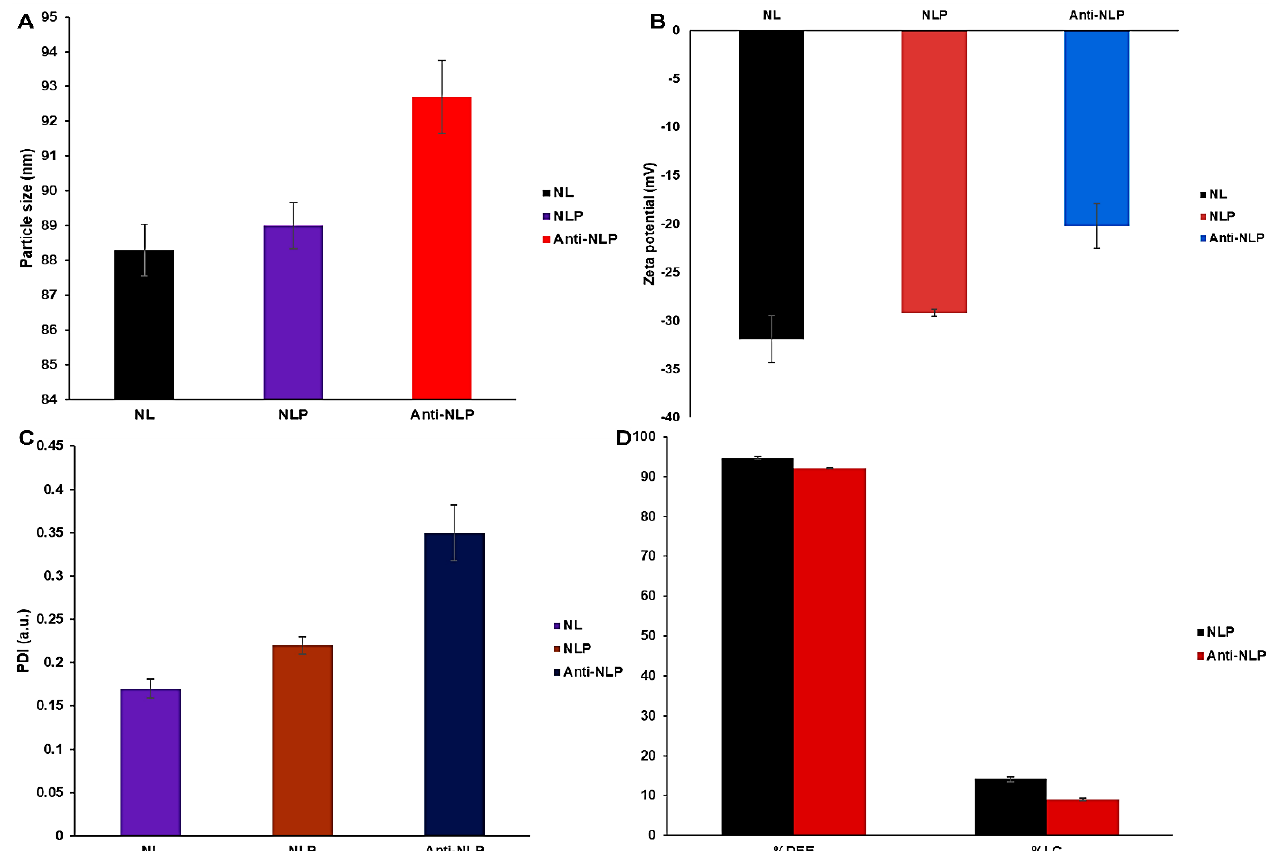
Figure 2. Particle size ( A ), zeta potential ( B ), PDI ( C ) of unloaded, PZQ-loaded, and Anti-calpain- PZQ-loaded nanoliposomes, and ( D ) the drug entrapment efficacy and drug loading capacity. PDI means polydispersity index, NL represents unloaded nanoliposomes, NLP means PZQ-loaded nanoliposomes, and AntiCal-NLP represents the Anti-calpain-engineered PZQ-loaded nanoliposomes. %DEE refers to drug entrapment efficacy, and %DLC refers to drug-loading capacity.